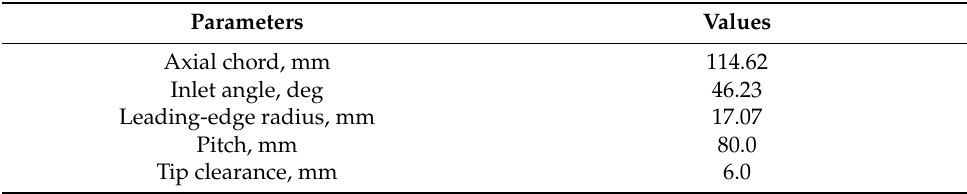
Table 1. Dimensions of first stage turbine blade for simulation.